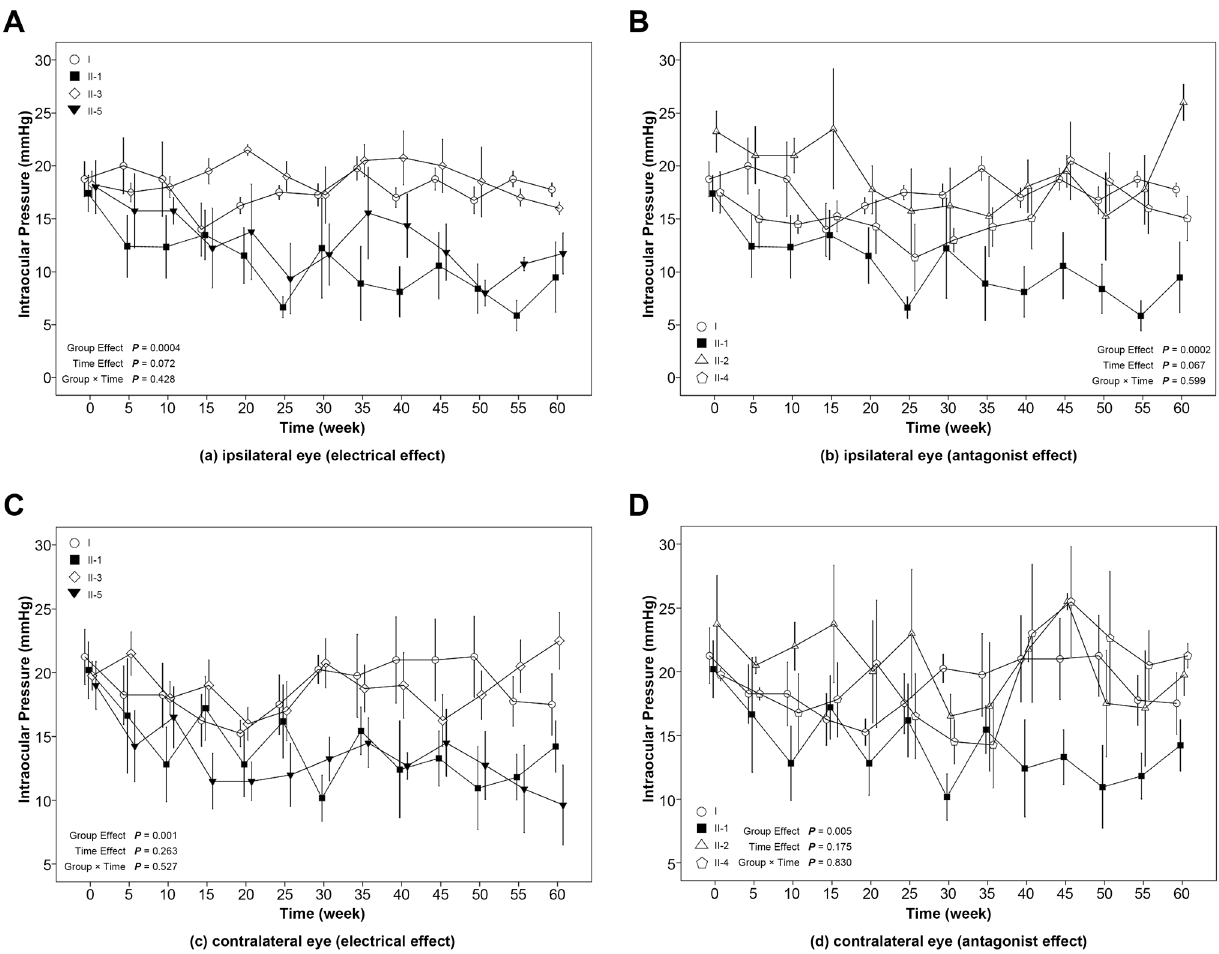
Figure 2. The effect of unilateral electrical stimulation of the ARC on intraocular pressure for the ipsilateral eye on electrical (a) Theerror-bar(mean 6 SE)ofeachgroup and antagonist (b) effects,and for thecontralateral eye onelectrical (c)andinantagonist was located at time points of 0, 5, 10, 15, 20, 25, 30, 35, 40, 45, 50, 55 and 60 minutes, respectively. A slight separation was made for error-bars at the same time points to avoid overlapping. I, Control group; II-1, electrical stimulation group; II-2, ARC naloxone + electrical stimulation group; II-3, ARC saline + electrical stimulation group; II-4, subconjunctival naloxone + electrical stimulation group; II-5, subconjunctival saline + electrical stimulation group.